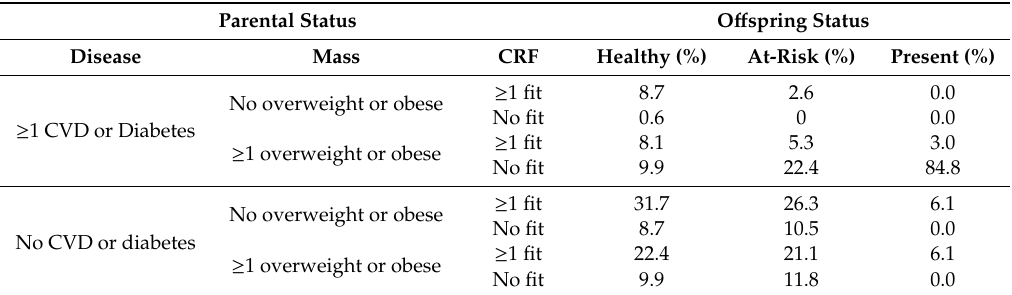
Table 4. Association between all three parental characteristics and metabolic syndrome